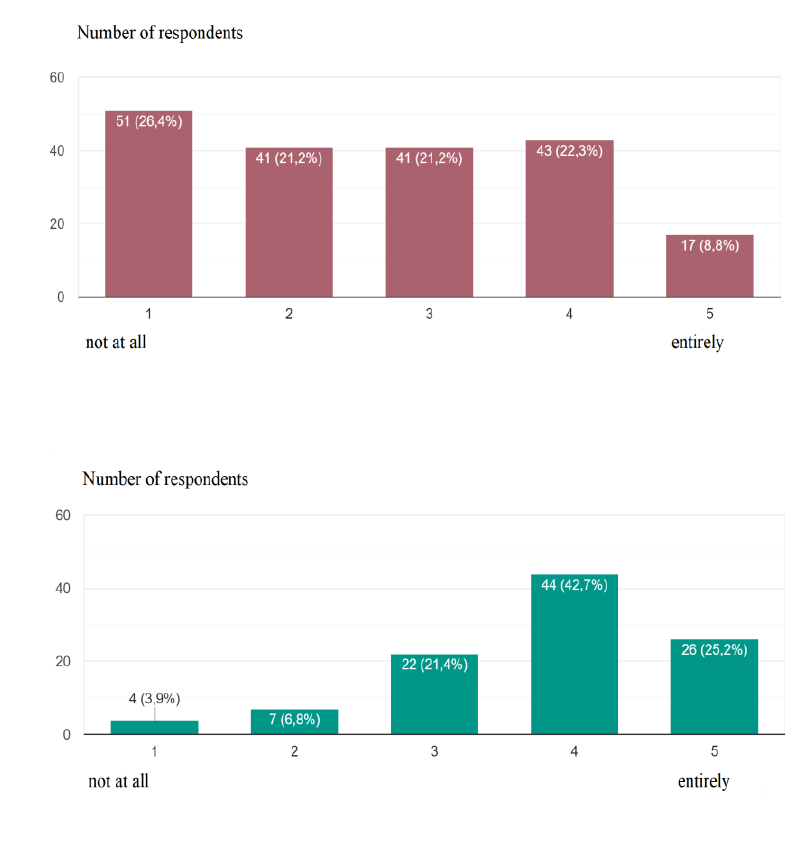
Fig. 6. Do you think the compulsory natural science subject at the final exam has positive im- pact on the knowledge level of